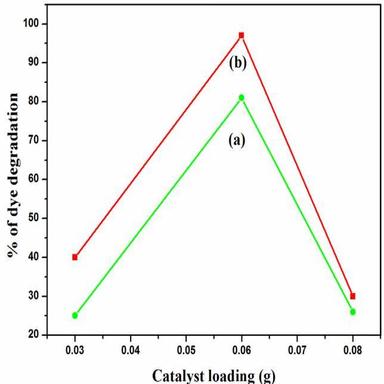
The effects of catalyst loading (a)SnO2 and (b)CdO-SnO2 nanocomposite material on NBB dye under UV-light irradiation at 365 nm.